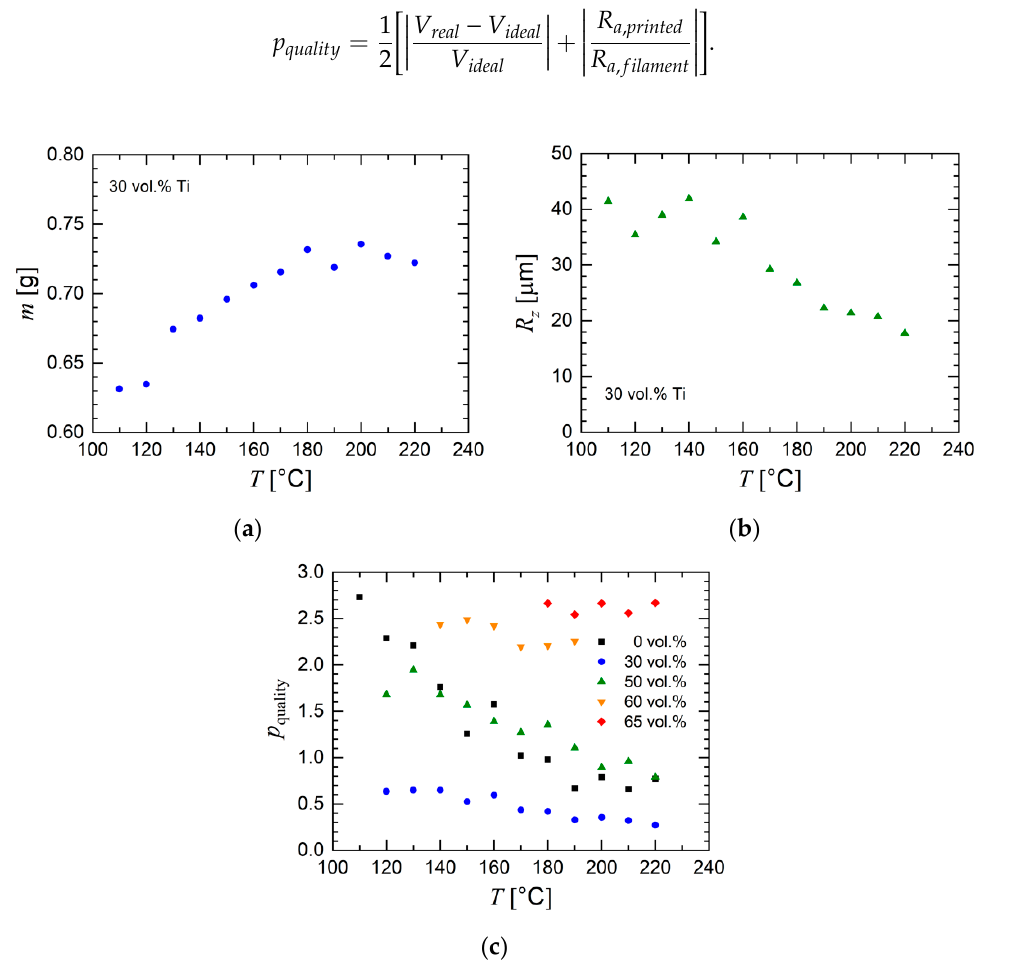
Figure 14. Influence of printing temperature on the quality of the printed green body. ( a ) Mass m and ( b ) roughness R z of the printed part for the feedstock with 30 vol.% titanium particles. ( c ) Value of the quality parameter (Equation (1)) as a function of temperature. The powder concentration is indicated.